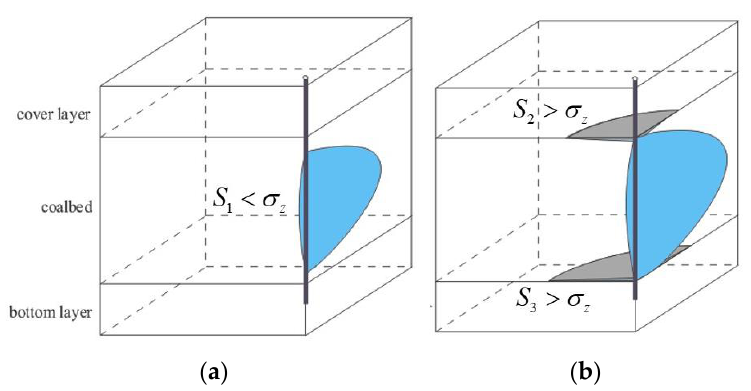
Figure 1. ( a ) shows the vertical component of I-shaped fracture which formed firstly due to the minimum principal stress being the minimum horizontal principal stress, and ( b ) shows the horizontal component of I-shaped fracture which formed firstly due to the minimum principal stress being the minimum horizontal principal stress in both cover and bottom layers. S 2 and S 3 are usually greater than S 1 , while there is little difference between S 2 and S 3 .